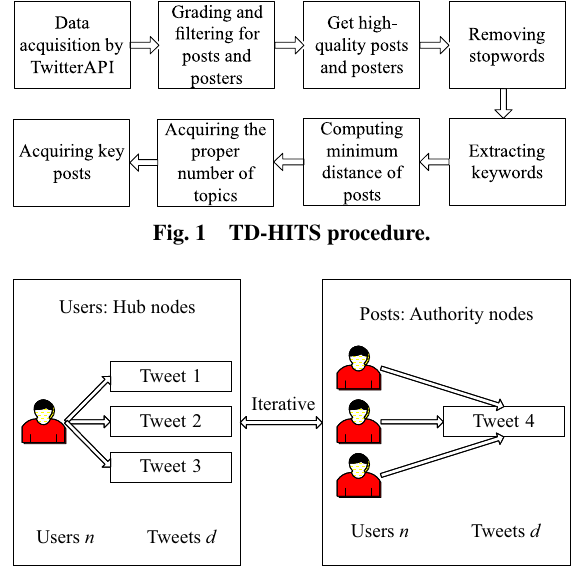
Fig. 2 Iterative model for determining the authority score of posts and the hub score of